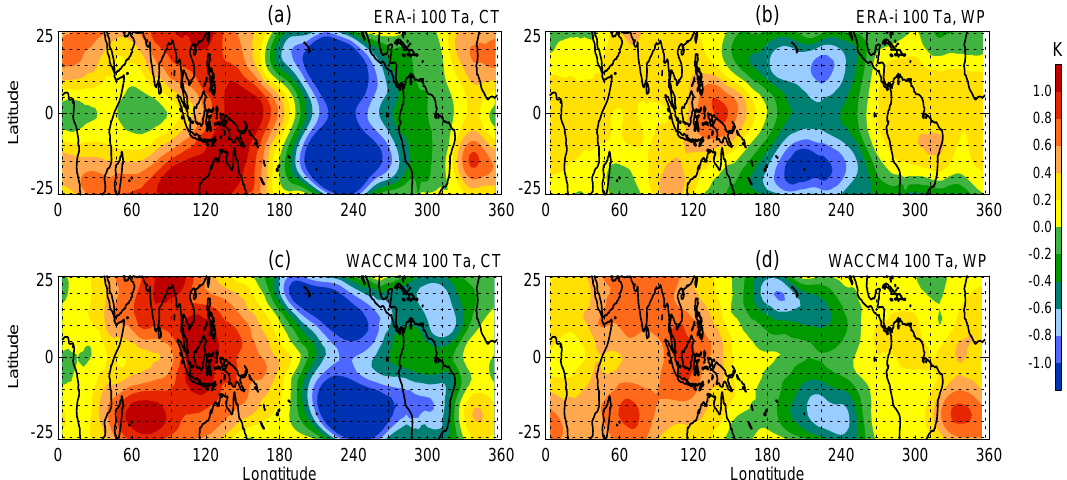
Fig. 4. Composite temperature anomalies at 100hPa for (a) canonical El Ni ˜ no events and (b) El Ni ˜ no Modoki events, based on ERA-Interim data for 1979–2010. Temperature anomalies at 100hPa for R2–R1 (c) and R3–R1 (d) . Contour interval, ±